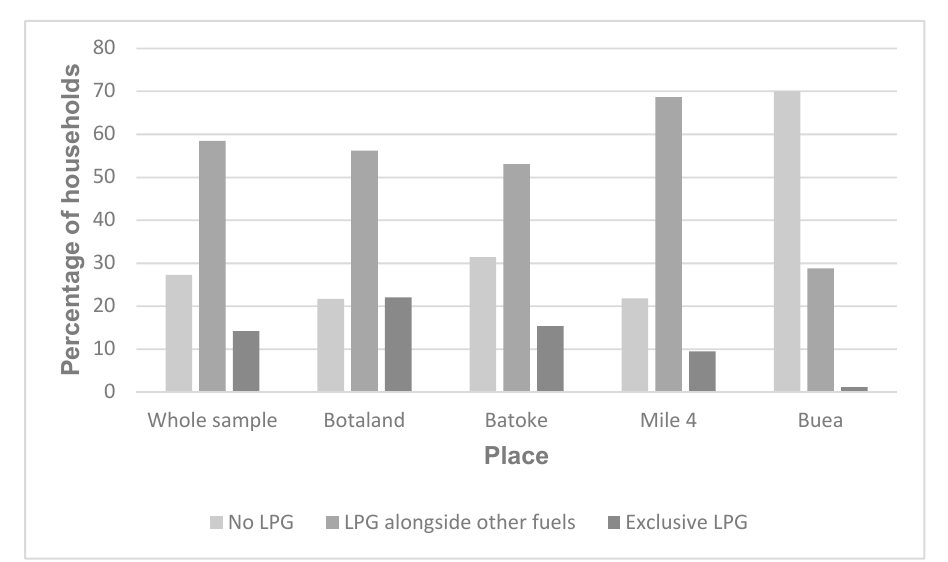
Figure 1. Reported degree of LPG use in the whole sample and by community (Buea is a rural community, and Botaland, Batoke and Mile 4 are all peri-urban communities).